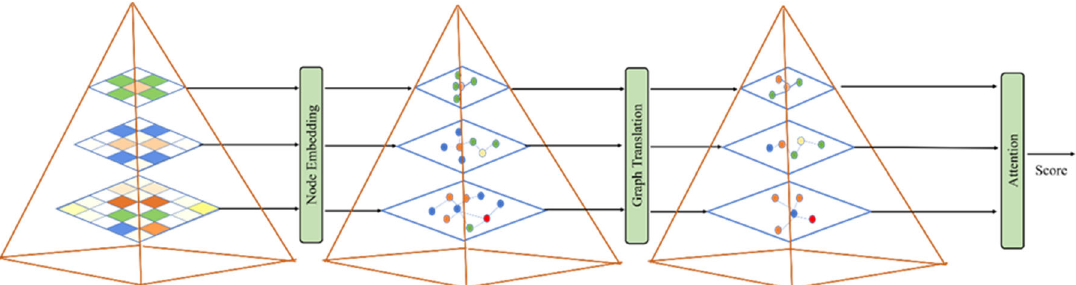
Figure 5. Graphic pyramid embedding operation.